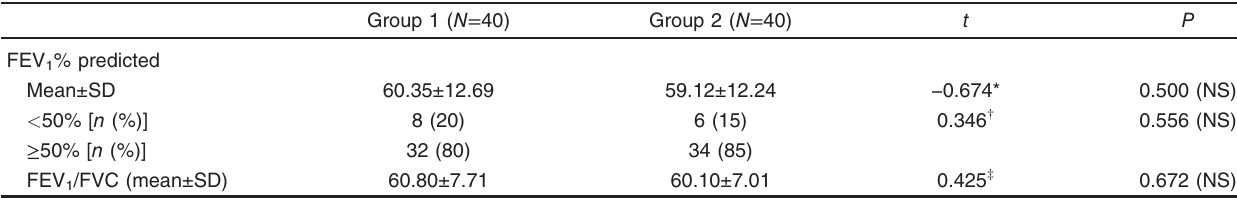
Table 3 Comparison between group 1 and group 2 regarding pretreatment spirometric function tests